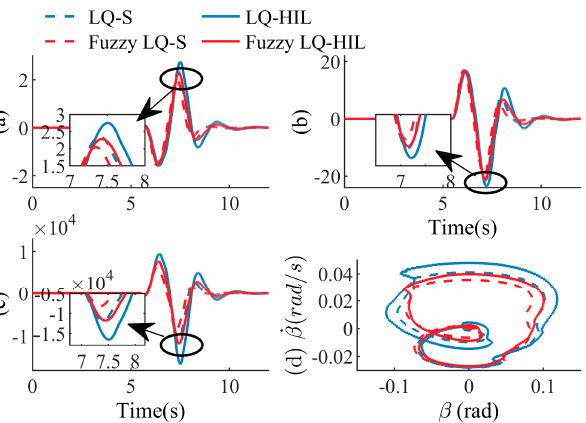
Figure 10. The control effect of single line—change condition. ( a ) Roll angle (deg); ( b ) Yaw rate (deg/s); ( c ) Active yaw moment (Nm); ( d ) β β− phase diagram.